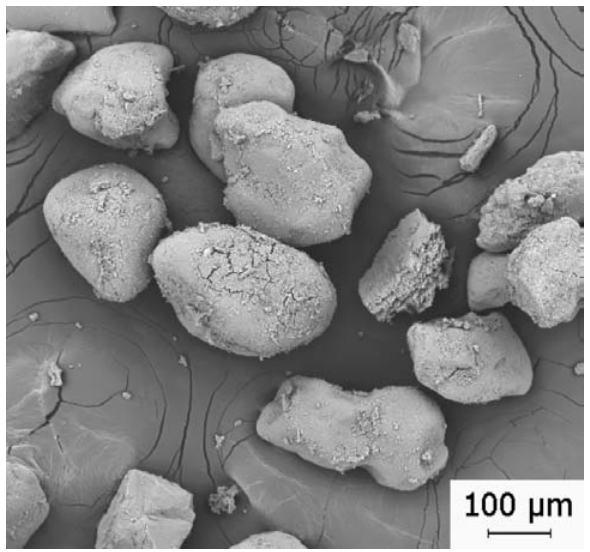
Figure 5. SEM micrograph of clay coating the sand grains.